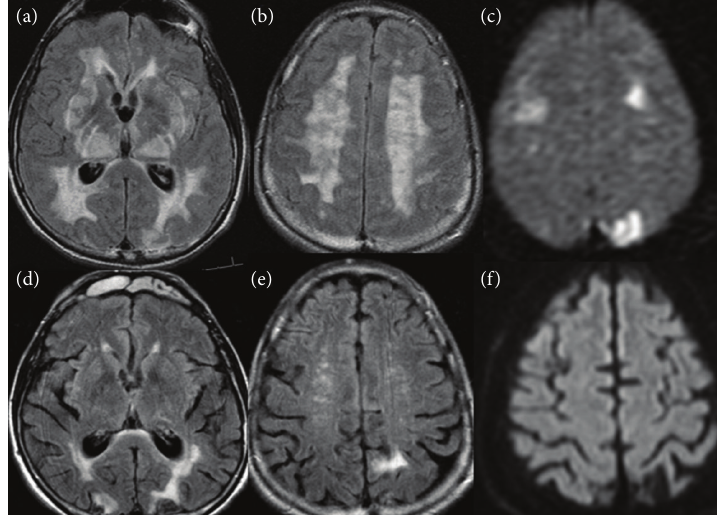
Figure 1: MRI findings at initial presentation (upper row) and follow-up (lower row). (a)-(b) Axial FLAIR images, taken at the levels of the hippocampi, mid lateral ventricles, and centrum semiovale, demonstrate confluent areas of abnormal high signal in the deep white matter with sparing of the subcortical white matter and overlying cortex. (d)-(e) Axial FLAIR images, at similar levels to (a)-(b), demonstrate marked decrease in the abnormal signal in the cerebral white matter. (c) shows small areas of restricted diffusion in the left greater than right medial parietal and bilateral frontal lobes, with apparent diffusion coefficient (ADC) correlation (f).